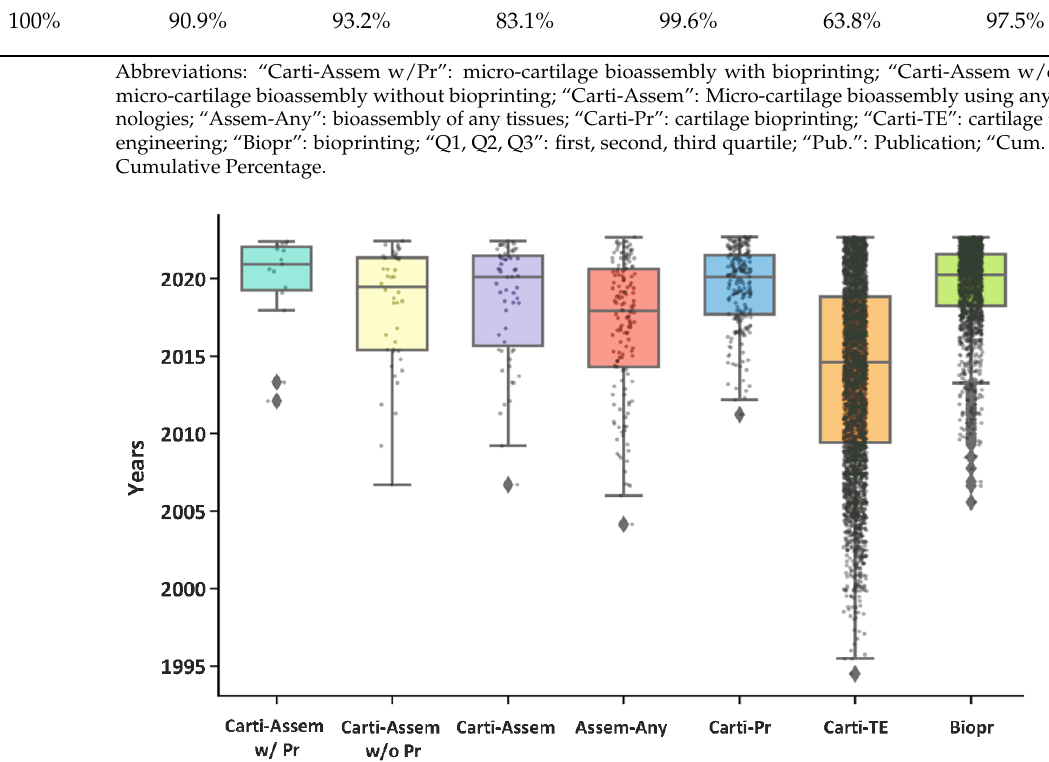
Figure 5. Box and strip plots of articles in each category. In each box, the top and bottom represent the first (Q1) and third (Q3) quartiles. The horizontal line inside the box is the median. Between Q1 and Q2 is the interquartile range (IQR), representing 50% of the articles. The whiskers extend 1.5 times the IQR beyond the top and bottom of the box, and outliers (diamonds) are beyond the whisk-